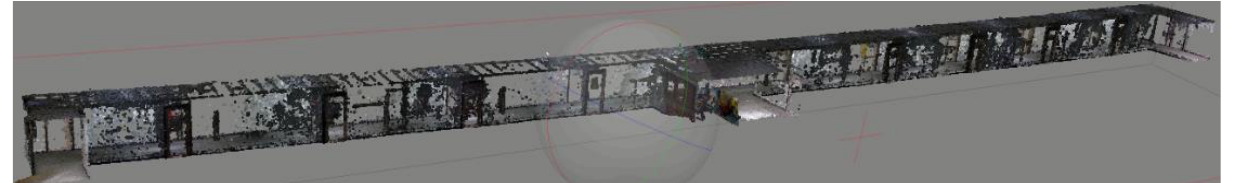
Figure 6. Dense cloud from unstitched and calibrated images with control scale bars to resolve the banana effect.